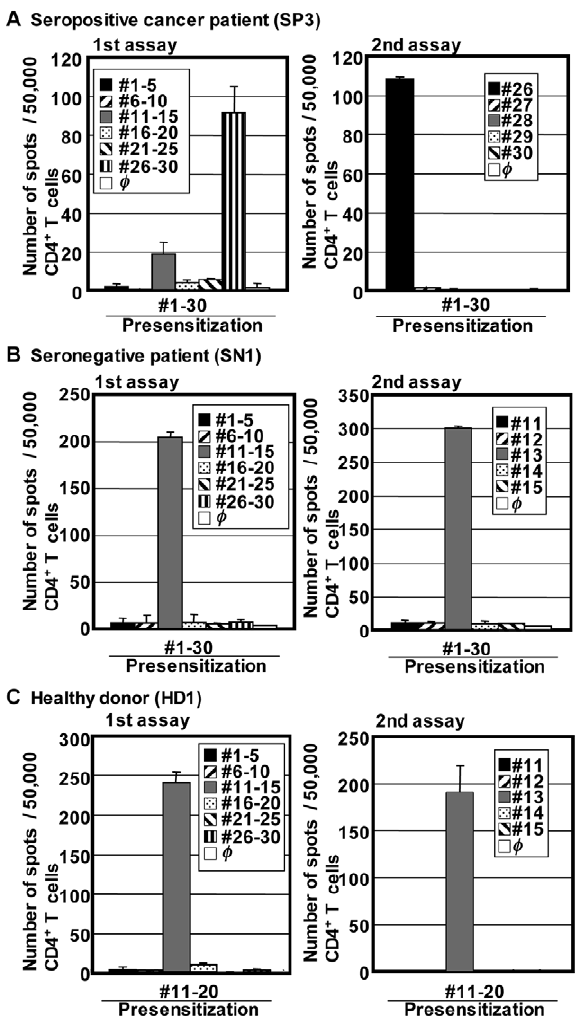
Figure 3. Detection of p53-specific CD4 + T cells in ovarian cancer patients and healthy donors. CD4 + T cells from antibody positive (A) and negative (B) ovarian cancer patients and healthy donors (C) were presensitized with pool(s) of p53 overlapping peptides. After 18–25 days, p53-specific IFN- c producing T cells were evaluated against peptide-pulsed or unpulsed ( w ) target cells by ELISPOT assays. Error bars represent SD of duplicate wells. Autologous T-APCs were used as target cells in ELISPOT assays. T cell responses were first evaluated against subpools of peptides (1st assay) and then against independent peptide in a reactive subpool (2nd assay). For the healthy donor shown in (C), CD4 + T cells that were presensitized with # 1– # 10 or # 21– # 30 peptide did not show any significant responses (data not